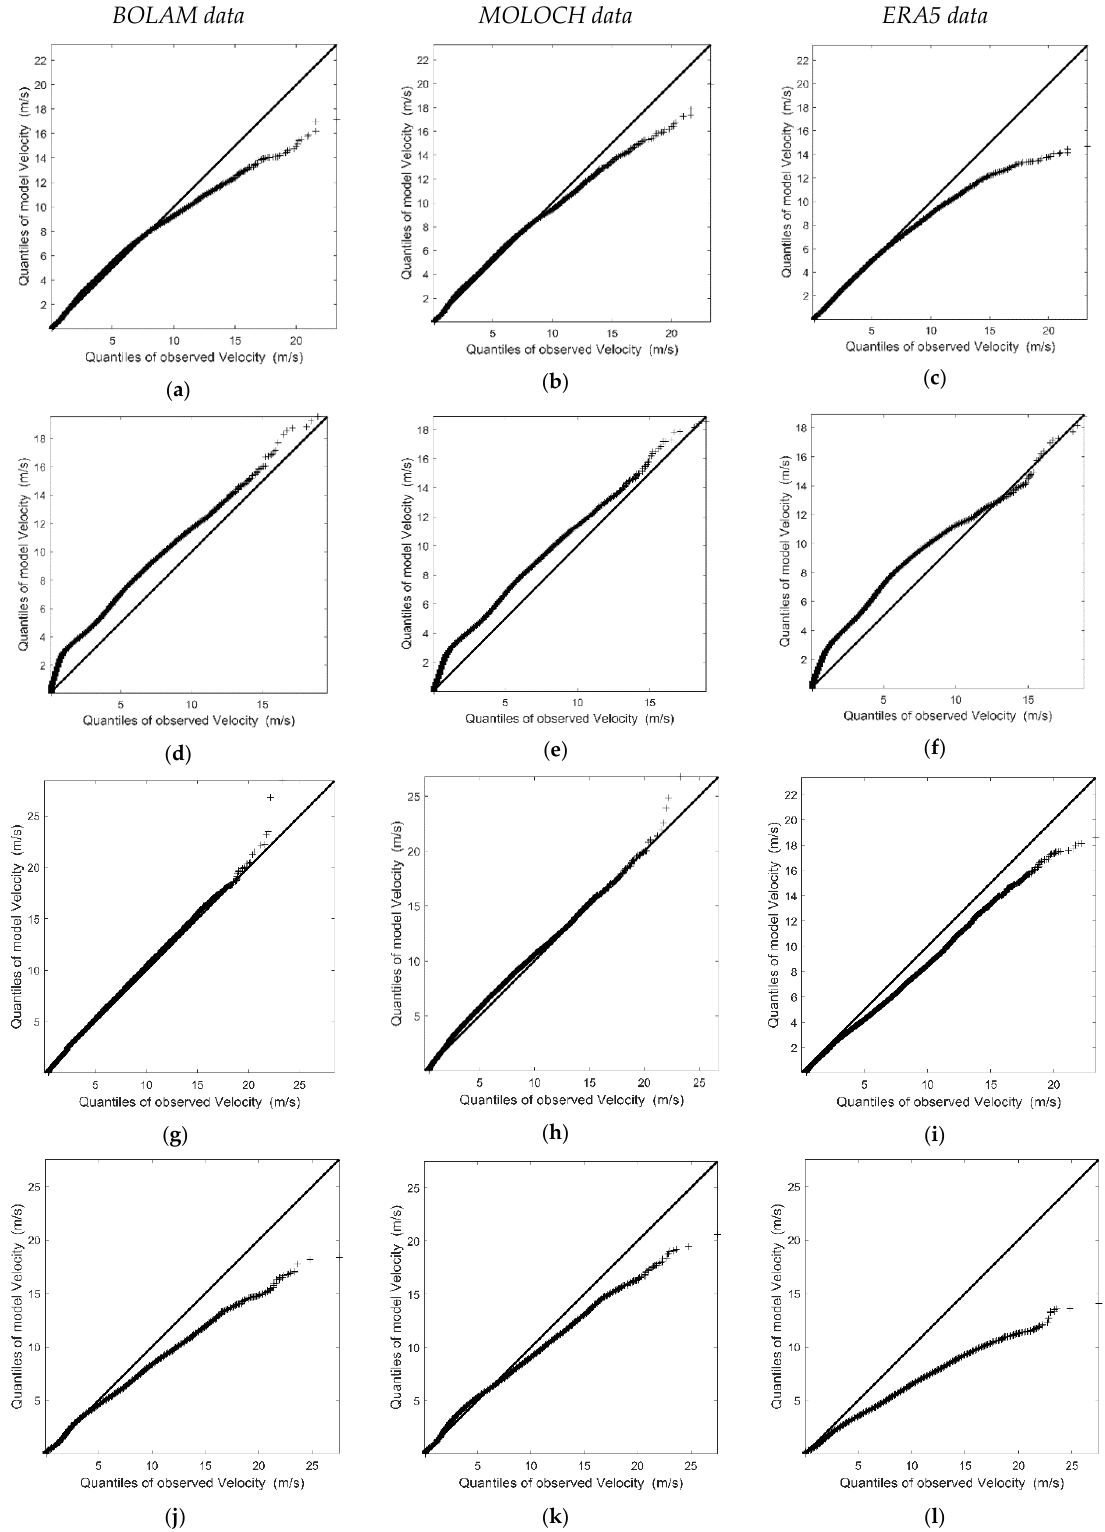
Figure 11. Quantile-quantile (Q-Q) plots of the BOLAM ( left ), MOLOCH ( center ) or ERA5 ( right ) wind speed against the observed data at: ( a – c ) Bocca d’Arno (no. 1), ( d – f ) Capalbio (no. 2), ( g – i ) Livorno offshore (no. 6) ( j – l ) and Vada (no. 11) wind stations. Horizontal and vertical axes report observed and modelled data, respectively.